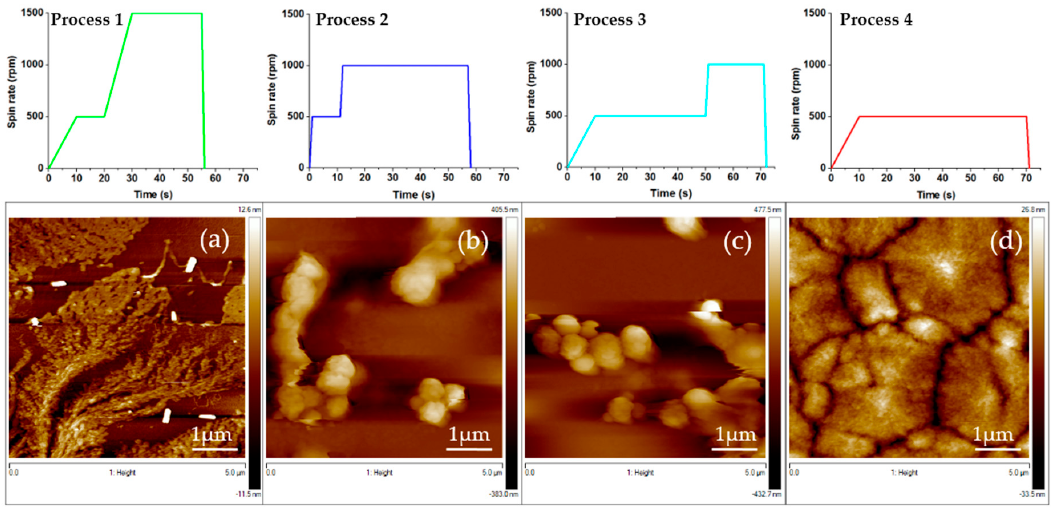
Figure 2. 5 × 5 µm AFM micrographs showing the morphology of PVDF spin-coated thin films with the corresponding spin coating processes on the top. Bottom: thin film obtained ( a ) by process 1; ( b ) by process 2; ( c ) by process 3; ( d ) by process 4.